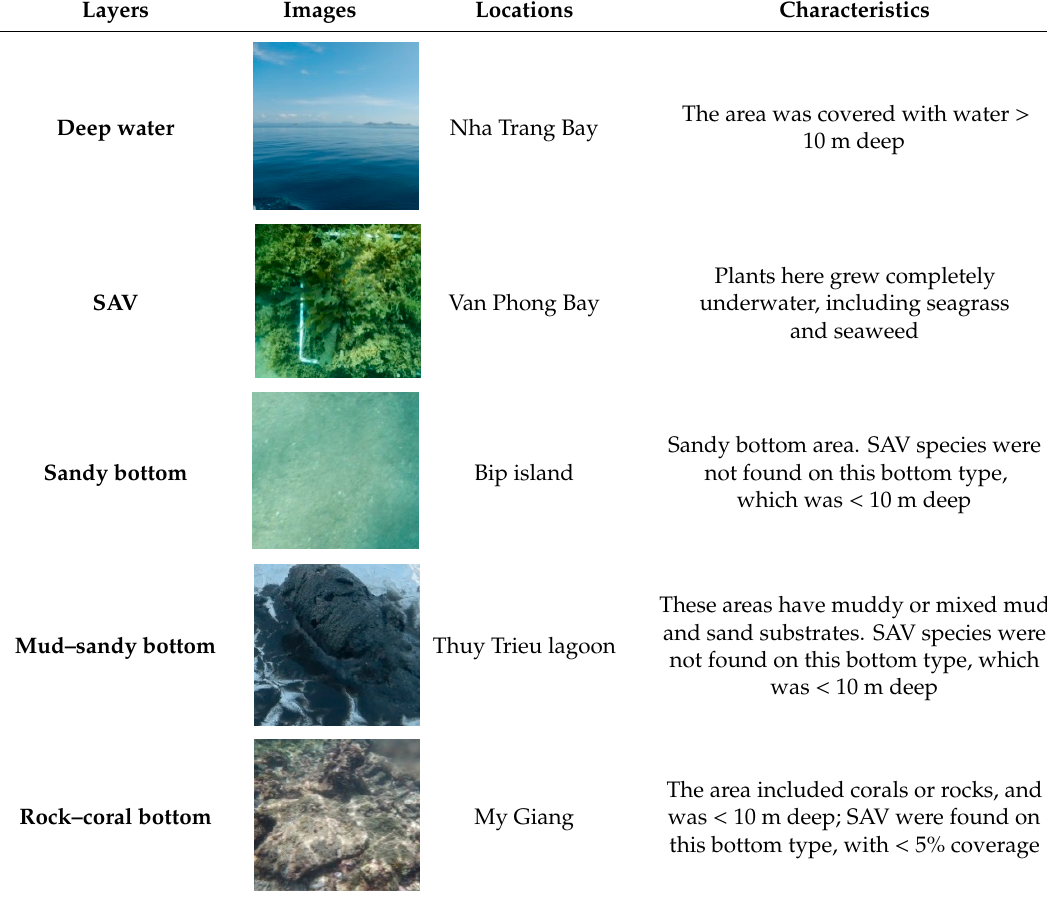
Table 3. Characteristics of ground truthing points in the Khanh Hoa coastal area.